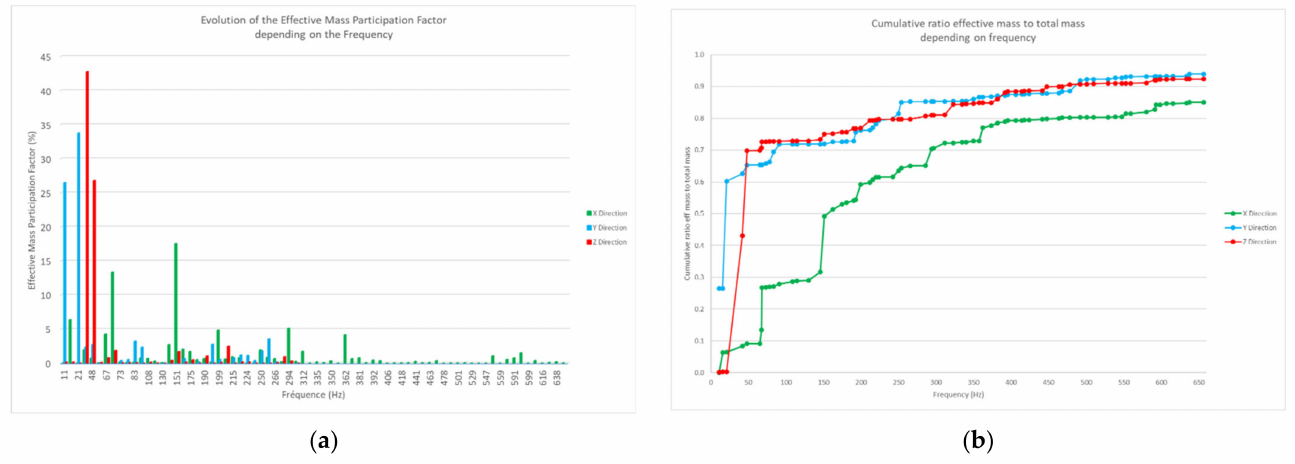
Figure 14. ( a ) Evolution of the effective mass participation factor; ( b ) cumulative ratio effective mass-to-total-mass.